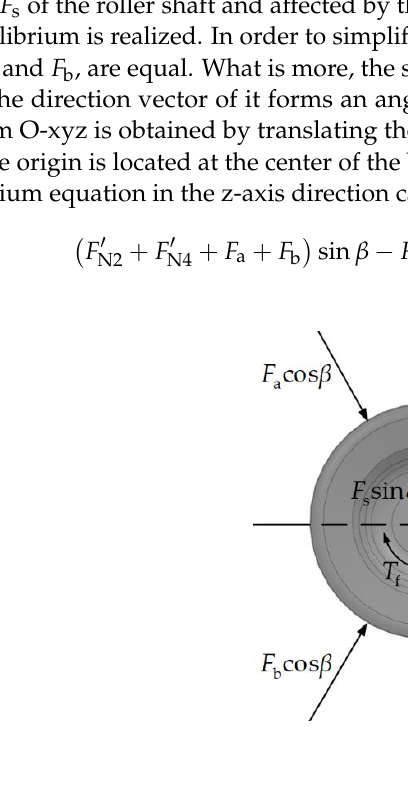
Figure 9. Force analysis of the cone roller: ( a ) schematic diagram of the forces acting on the cone roller; ( b ) projection of the forces.